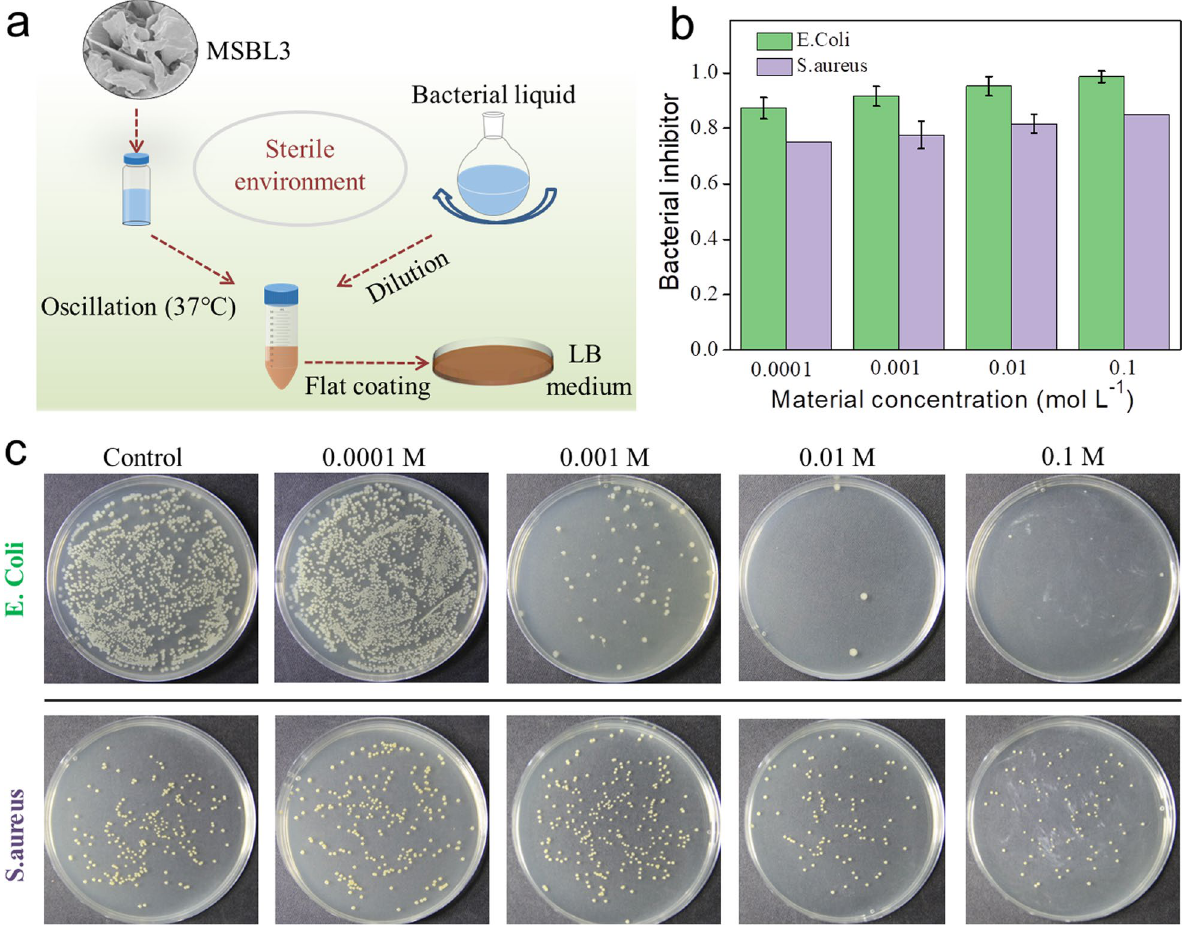
Fig. 7 a Flow chart of the antibacterial test; b , c Inhibition of E. coli and S. aureus at different concentrations of